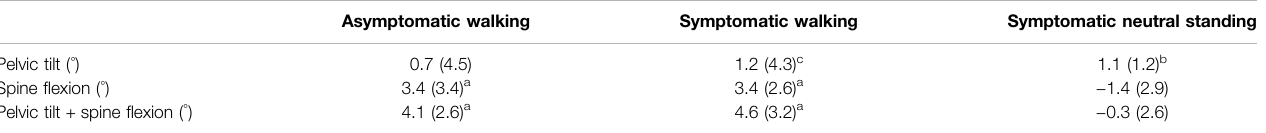
TABLE 3 | Mean (SD) of average postural measurements (forward pelvic tilt, spinal fl exion, and pelvic tilt + spinal fl exion) relative to asymptomatic neutral standing, in asymptomatic walking, symptomatic walking, and symptomatic neutral standing. Asymptomatic